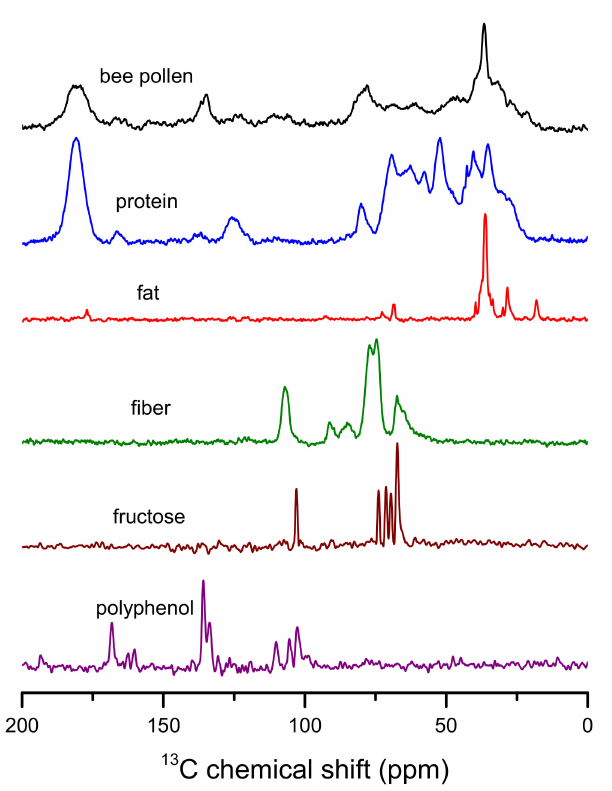
Figure 2. 13 C CPMAS NMR spectra of bee pollen and reference compounds. Protein: soy protein isolate; fat: coconut oil; fiber: wheat fiber; polyphenol: gallic